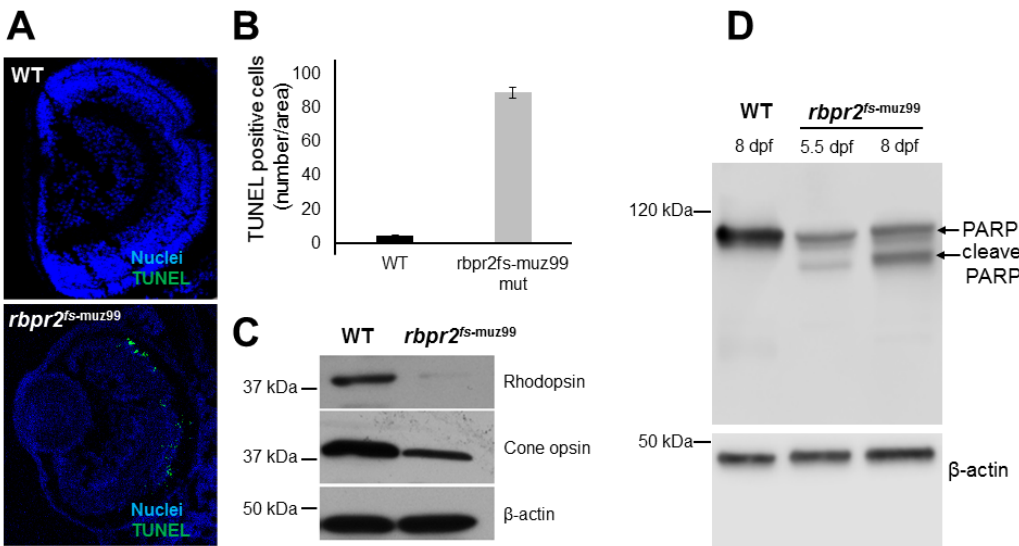
Figure 9. Detection of apoptosis in retinas of rbpr2 fs-muz99 mutants. ( A ) Wild-type (WT) and rbpr2 mutant ( rbpr2 fs-muz99 ) zebrafish retinas at 5.5 dpf were stained with TUNEL reagent. The TUNEL positive cells / apoptotic nuclei stain green. ( B ) Quantification of TUNEL positive cells. ( C ) Determination of rod and cone opsin levels in WT and mutant eyes (dissected heads; n = 12 each genotype) by Western blot analysis at 8 dpf. ( D ) Total protein from WT and mutant eyes (dissected heads; n = 12 each genotype), at the 5.5 and 8 dpf time-points, were pooled and subjected to Western blot analysis using PARP1 antibody. Cleaved PARP1 products in rbpr2 fs-muz99 mutant eyes indicate apoptosis. TUNEL assays and Western blot experiments were repeated thrice. For Figure 9B, statistical analysis of data using the Mann–Whitney U test showed a p < 0.05 (medians are provided as Box-Whisker plots in Supplementary Figure S15).